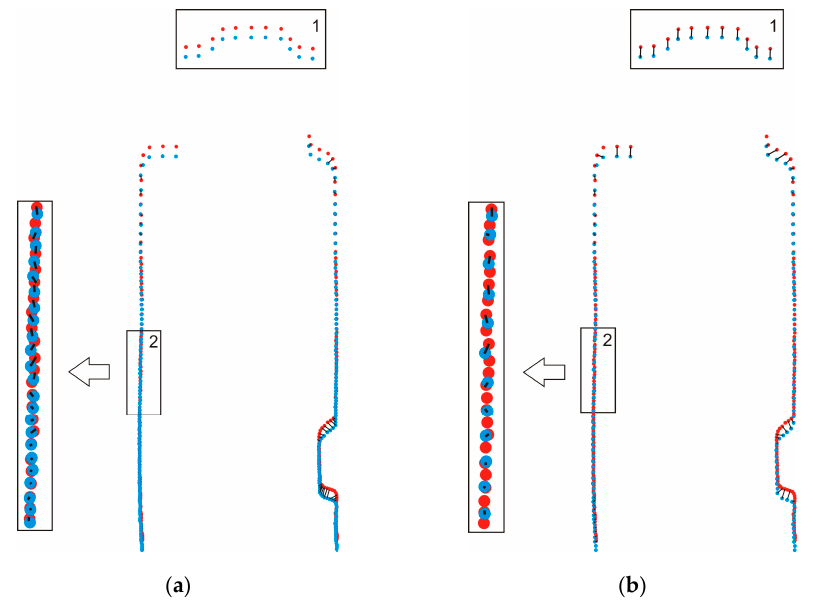
Figure 10. ( a ) Rejection result without the resampling step (red dots-reference scan, blue dots-object scan, black lines-correspondences); ( b ) rejection result with the resampling step (red dots-reference scan, blue dots-object scan, black lines-correspondences).